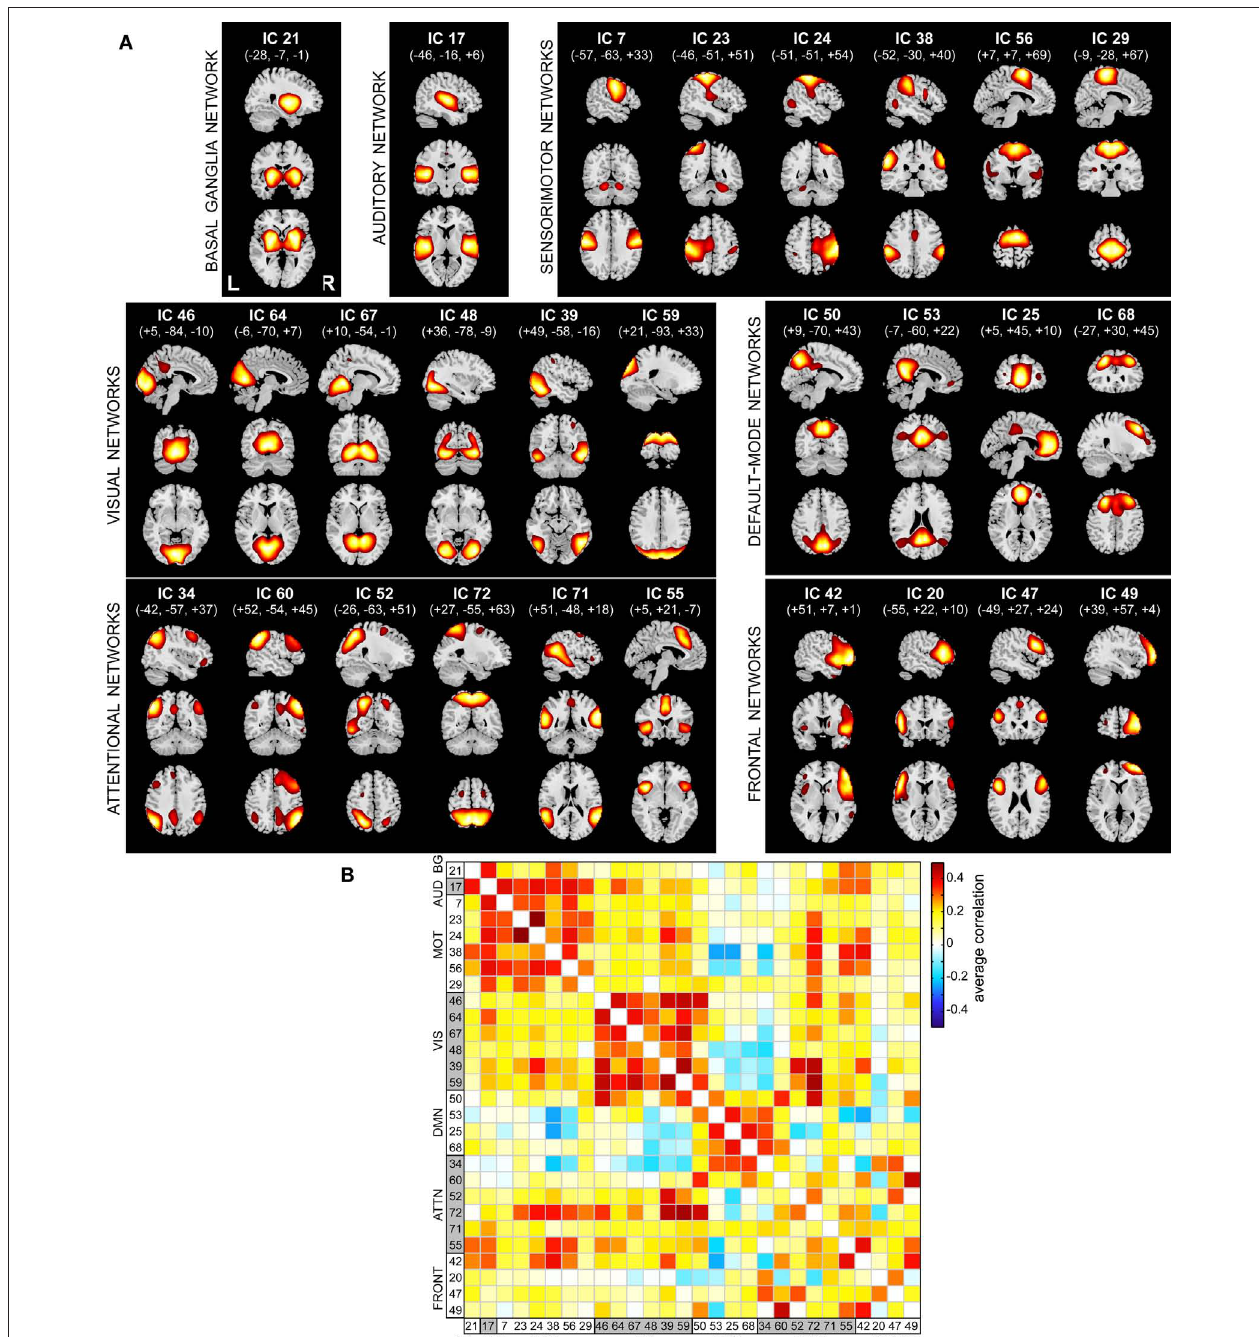
auditory (AUD), sensorimotor (MOT), visual (VIS), default-mode (DMN), attentional (ATTN), and frontal (FRONT) networks. (B) Functional network connectivity matrix. Pairwise correlations between RSN TCs were Fisher z -transformed and averaged across subjects, then inverse z -transformed for